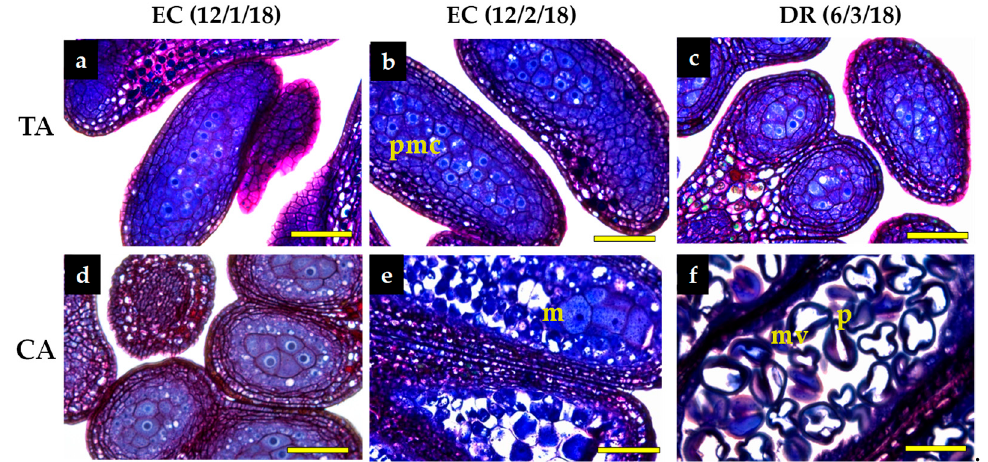
Figure 1. Histological analysis of flower bud evolution from peach cultivar ‘GEM020’ Samples were collected from a temperate (TA) ( a – c ) and a cold area (CA) ( d – f ) during ecodormancy (EC) ( a , b , d , e ) and dormancy release (DR) ( c , f ) m = microespore; vm = vacuolated microspore; pmc= pollen mother cell; p = pollen grain. Bars’ length corresponds to 50 µm.